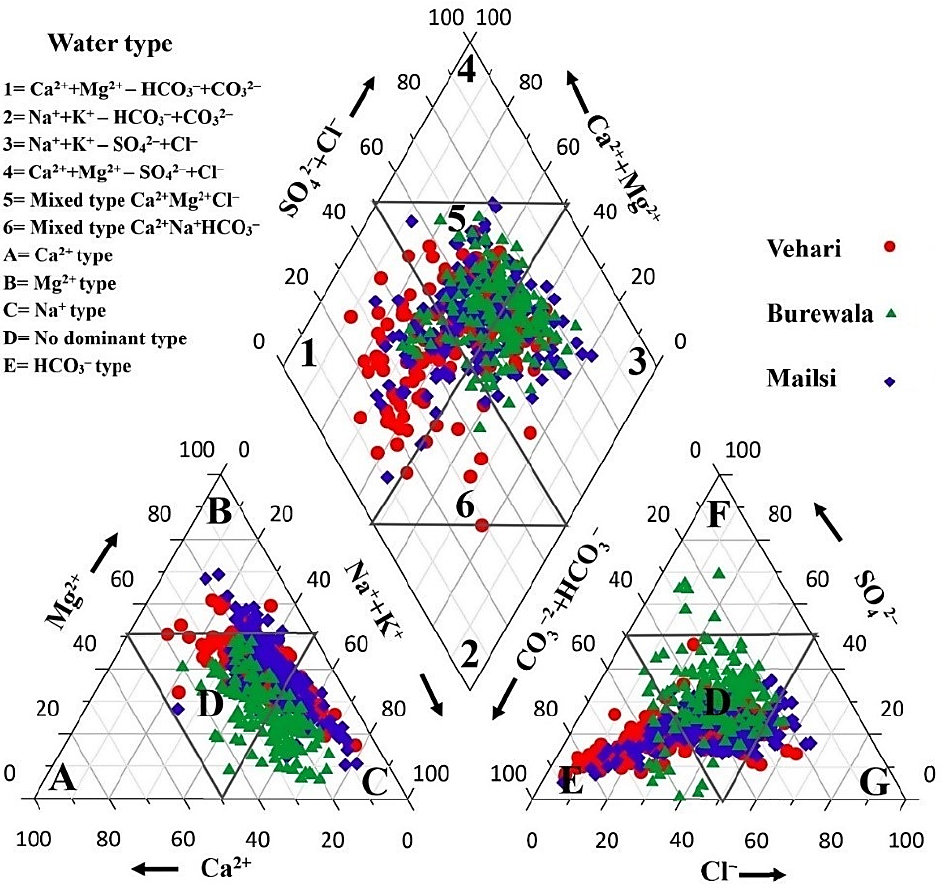
Figure 2. Piper diagram showing groundwater chemistry in study area.